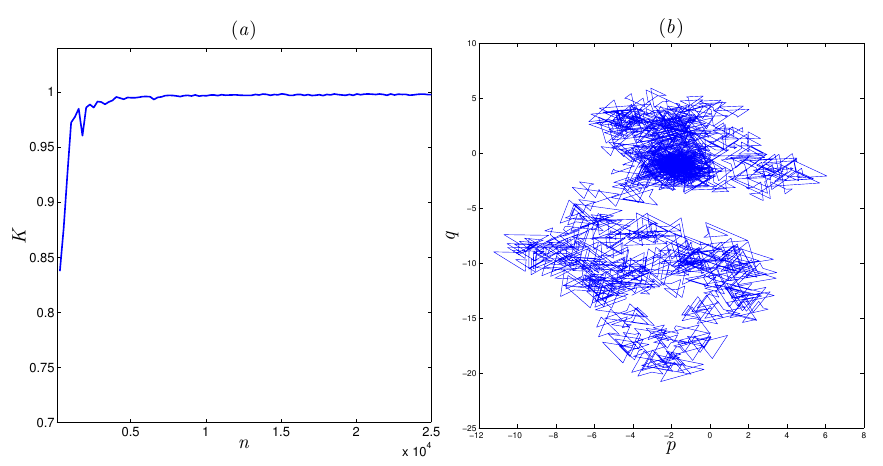
Figure 6. The 0–1 test of the FoDS given in (7), when γ = 0.998, A = 0.7 and B = 0.9; ( a ) The dependence of the rate of asymptotic growth K on the iteration number n , ( b ) The Brownian motion in the p − q plane.